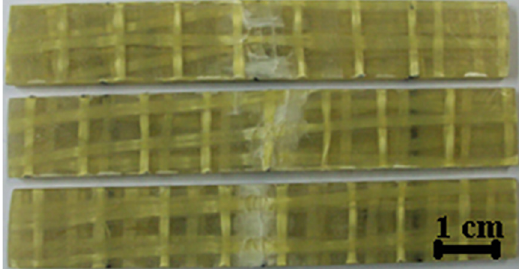
Figure 16. Fracture characteristic – HFCL laminate – three-point bending.